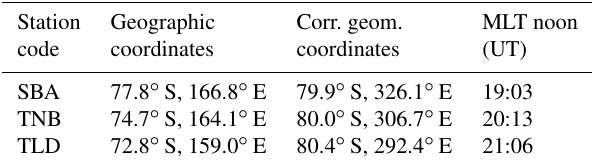
Table 1. Geographic coordinates, IGRF08 corrected geomagnetic coordinates and time in UT of the geomagnetic local noon for the three